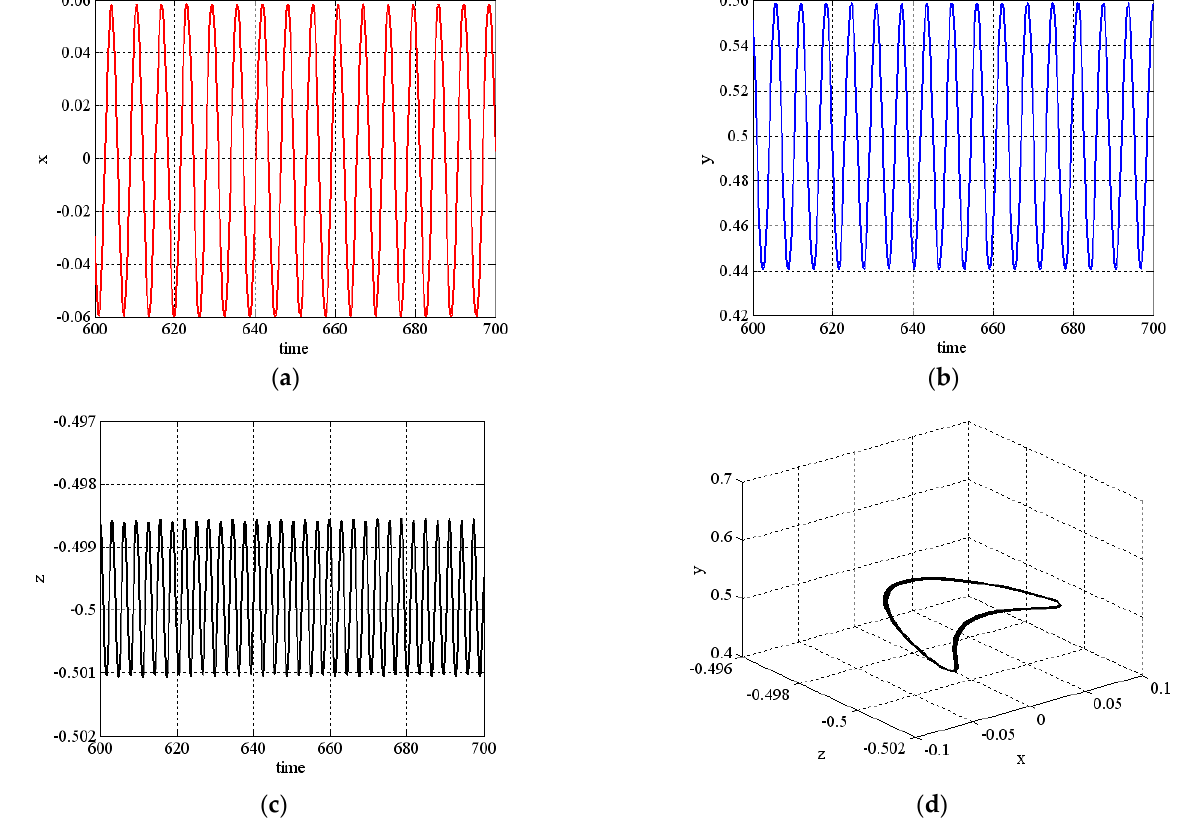
Figure 3. Stable limit cycle for system (1) (for coordinate x ( a ); for coordinate y ( b ), for coordinate z ( c ) and phase space ( d )) when a = − 1.51 and b = 0.75. Note that for these values of a and b , R ( 2 ) = − 0.01.